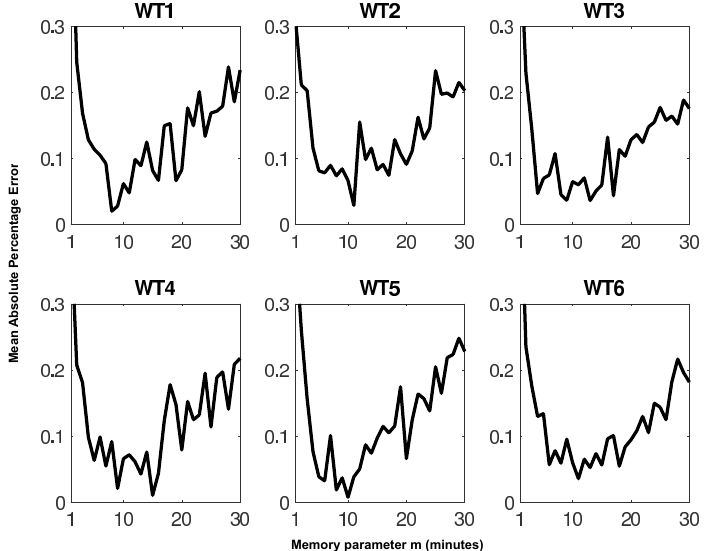
Figure 5. Mean absolute percentage error (MAPE) between real and simulated autocorrelation functions as a function of the memory parameter m for each power